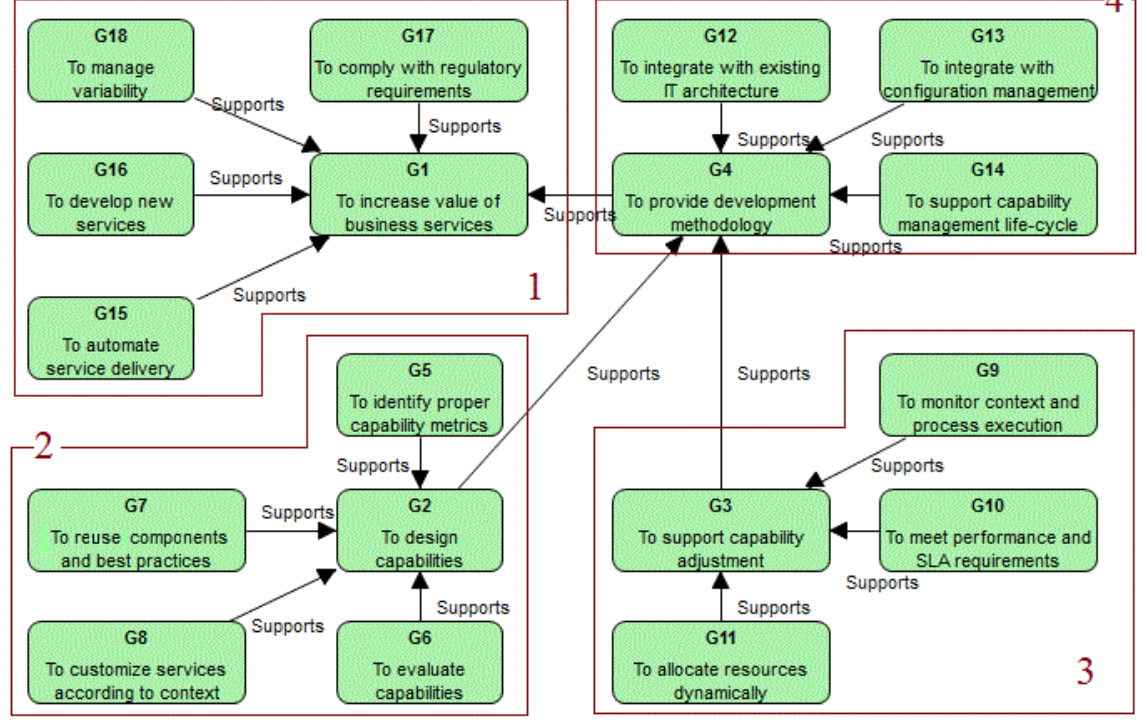
Figure 1. Goal model showing the need for approaches based on